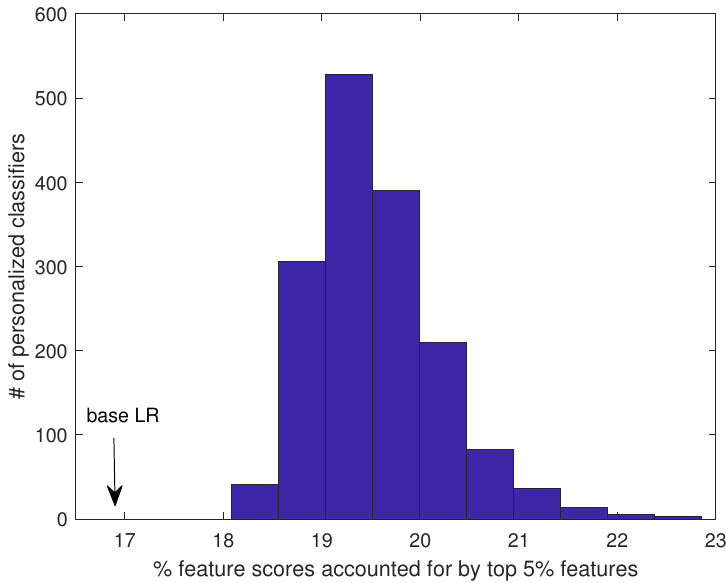
Figure 10. Percent of total feature scores accounted for by the top 5% features in PC vs. base